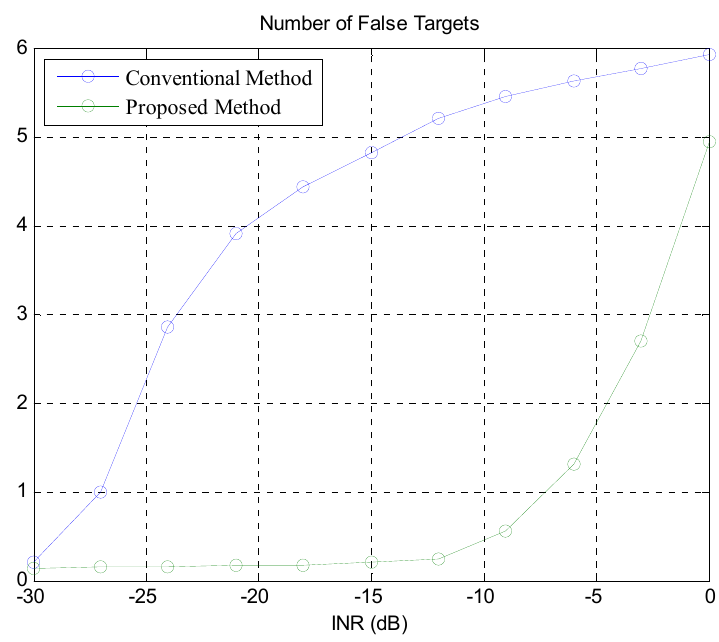
Figure 9. Average number of the false targets of the proposed and conventional methods.